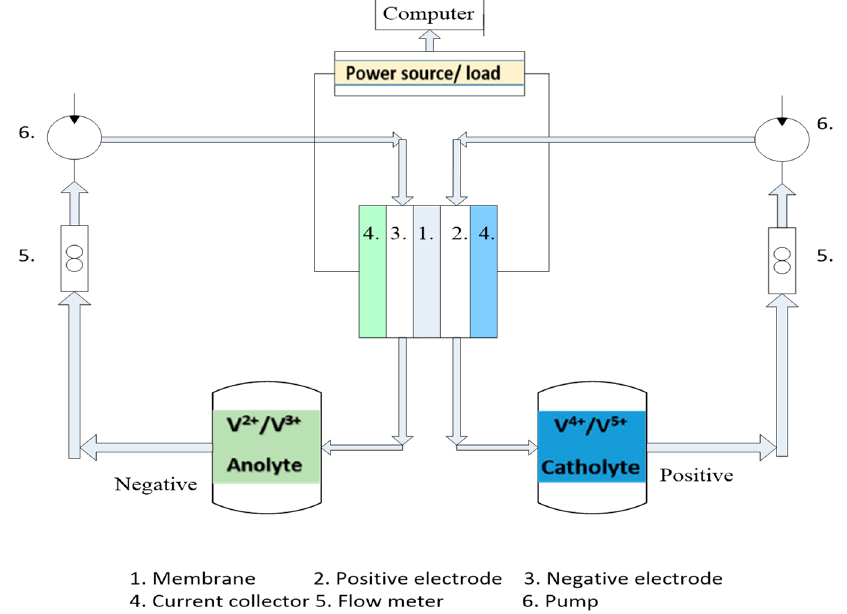
Figure 4. Schematic layout of experimental instruments.